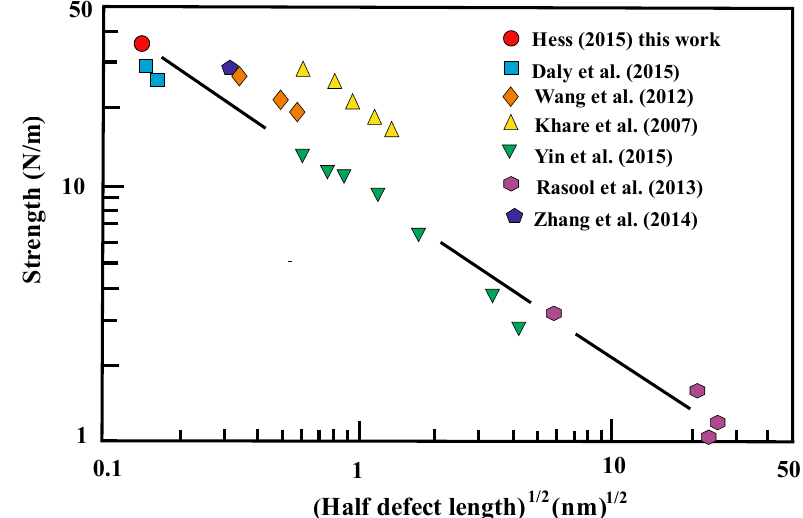
Figure 1: Intrinsic stress of perfect [4] and critical engineering stress of defective graphene containing vacancies [10,20], slits [12], grain boundaries [15], and pre-cracks studied theoretically by DFT and MD calculations [17] and experimentally by nanoindentation [16]. The straight line is a guide to the